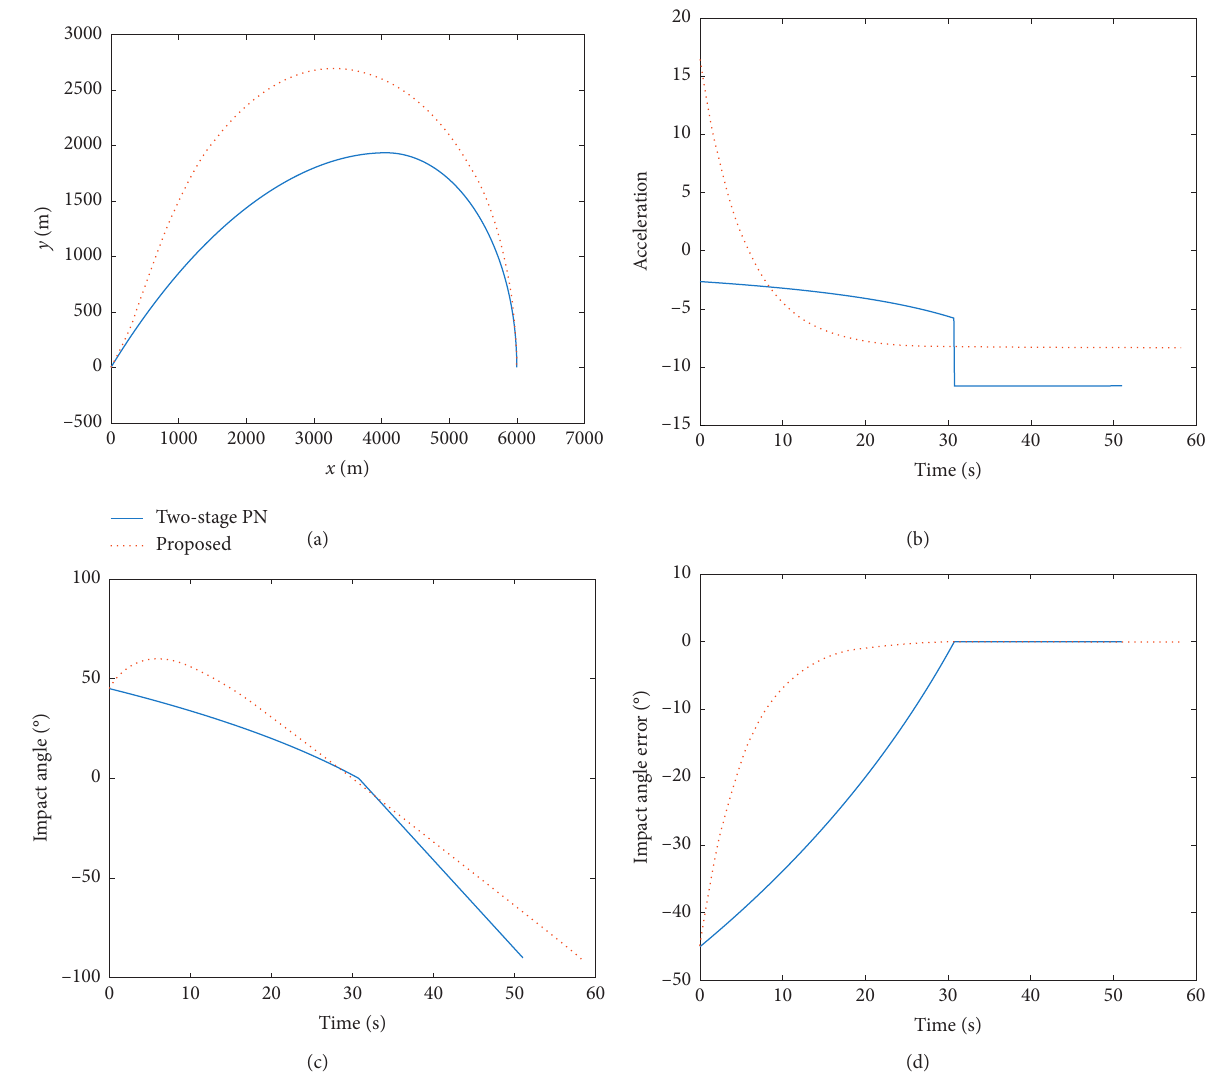
Figure 4: Comparison results. (a) Trajectories. (b) Acceleration. (c) Impact angle. (d) Impact angle